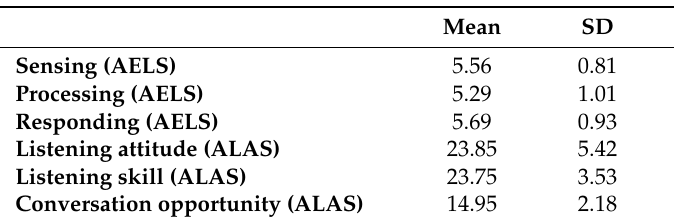
Table 2. Mean values for Active Empathic Listening Scale (AELS) and Active Listening Attitude Scale (ALAS) dimensions.